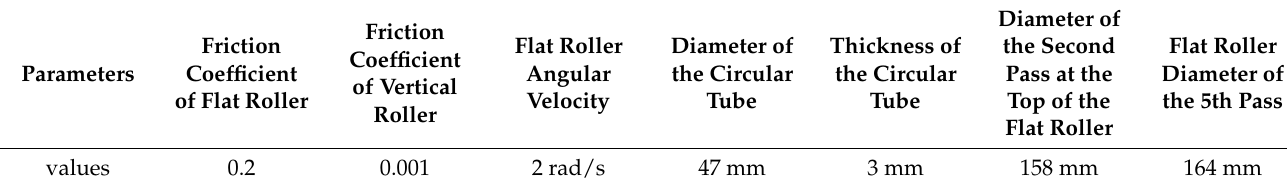
Table 3. Roll forming parameters.